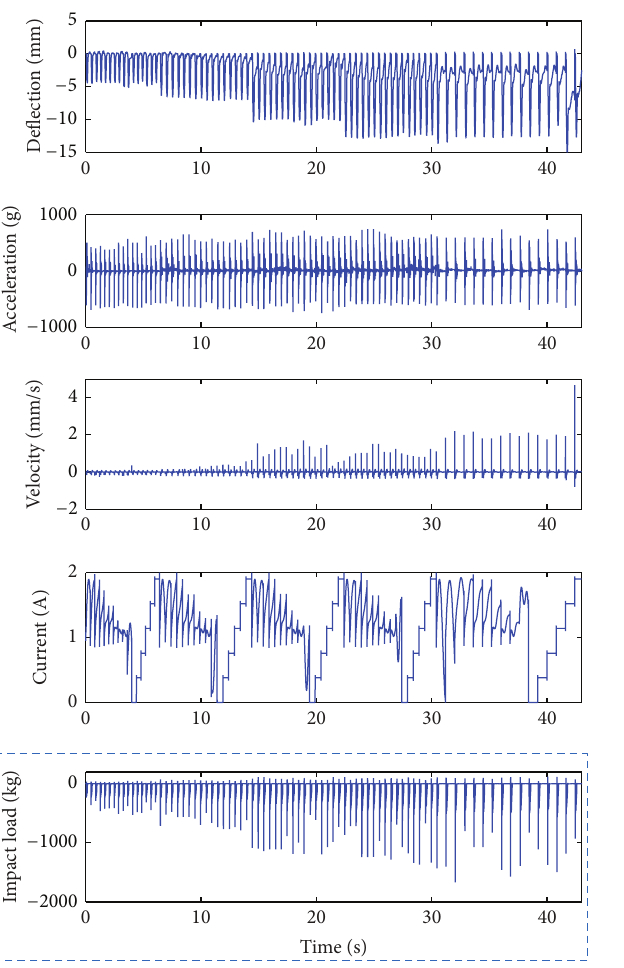
Figure 9: Input-output data sets to train the neurofuzzy models.